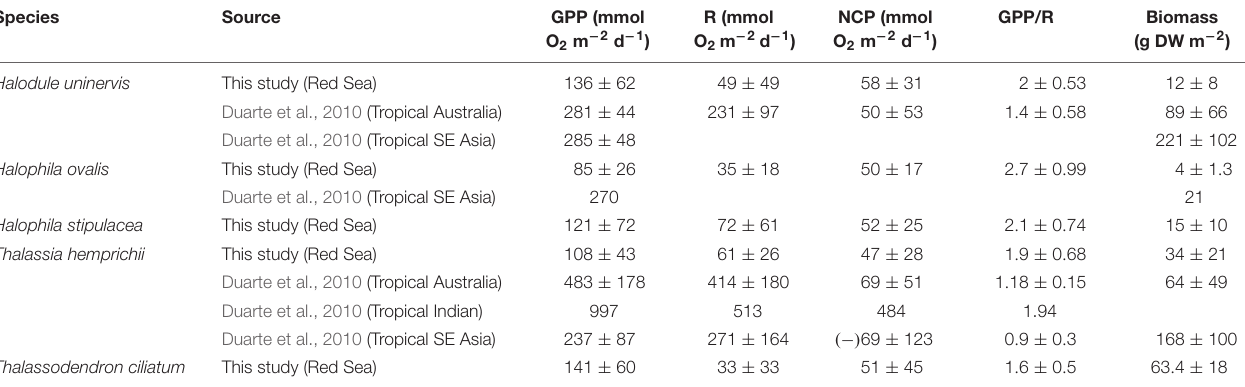
TABLE 1 | Comparison of the mean ( ± SD) metabolic rates of seagrass species in the Red Sea with their global average reported in Duarte et al. (2010).